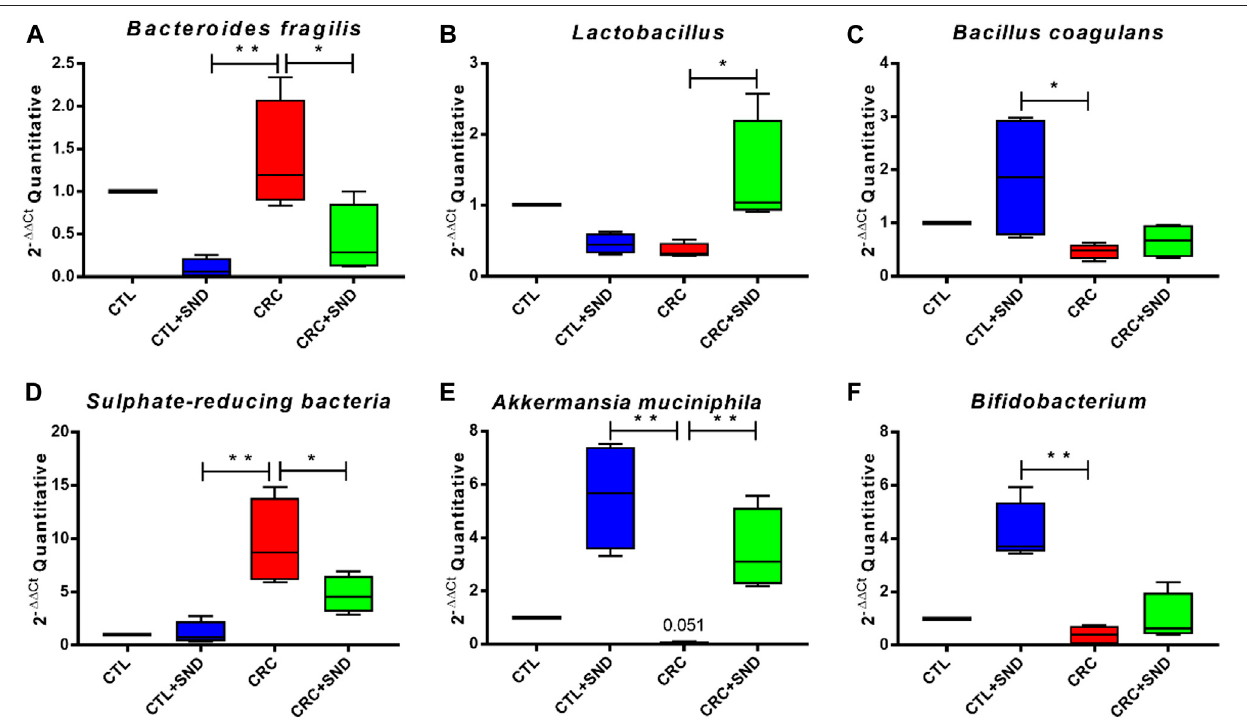
FIGURE 8 | RT-qPCR examination for the screened species. (A) The relative abundance of Bacteroides fragilis in different groups. (B) The relative abundance of Lactobacillus in different groups. (C) The relative abundance of Bacillus coagulans in different groups. (D) The relative abundance of Sulphate-reducing bacteria in differentgroups. (E) Therelativeabundanceof Akkermansiamuciniphila indifferentgroups. (F) Therelativeabundanceof Bi fi dobacterium indifferentgroups.Compared to CRC group, * p < 0.05, ** p < 0.01.